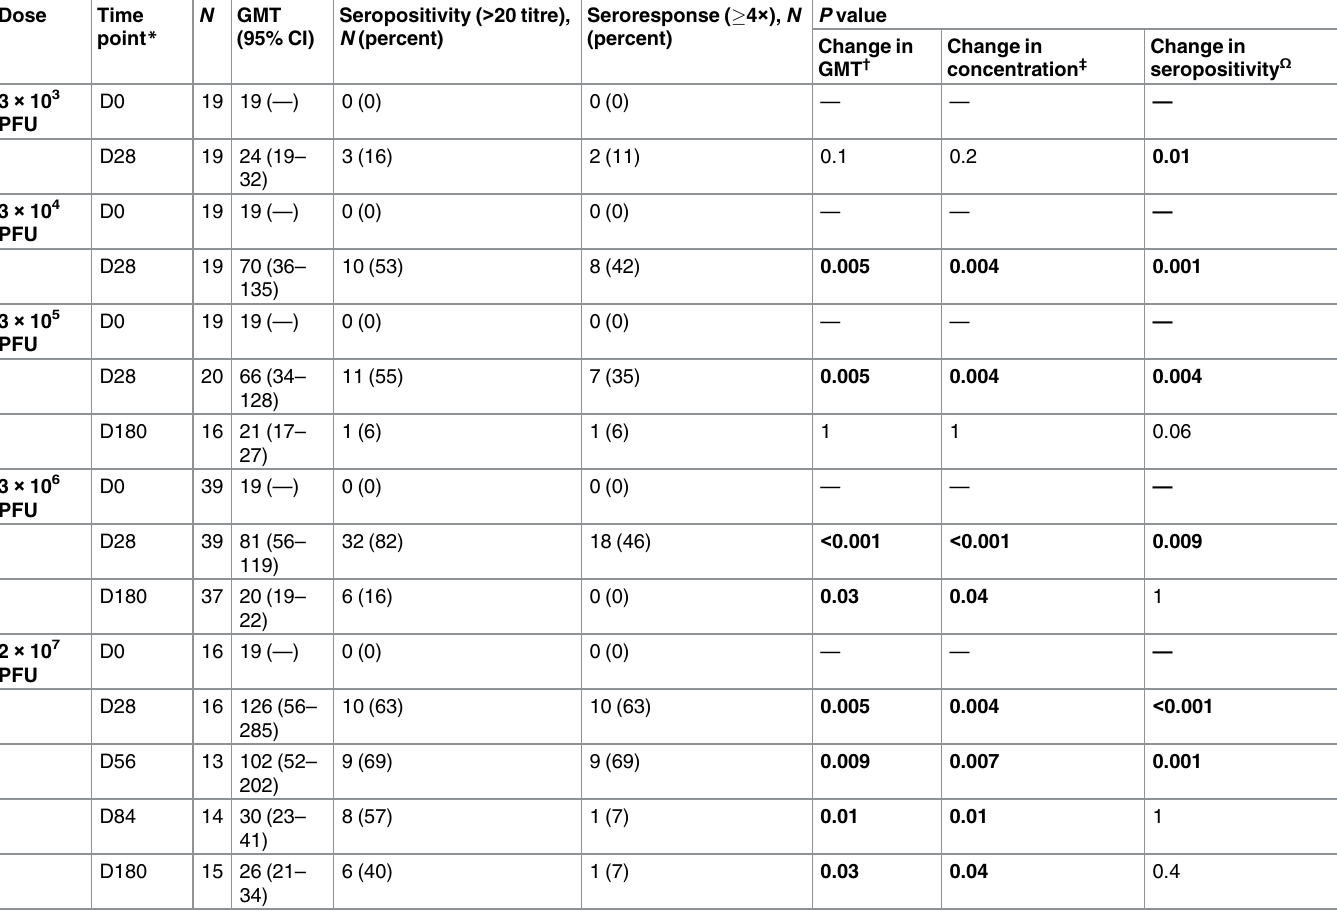
Table 7. Geometric mean titres, seropositivity rates, and proportions of seroresponders to rVSV Δ G-ZEBOV-GP measuredby ZEBOV PsVNA50in adults. Dose Time point